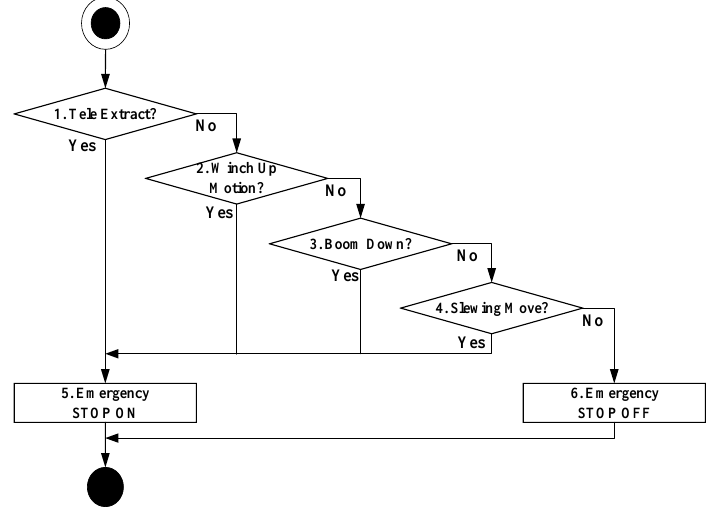
Figure 8. Overload detection and control algorithm.